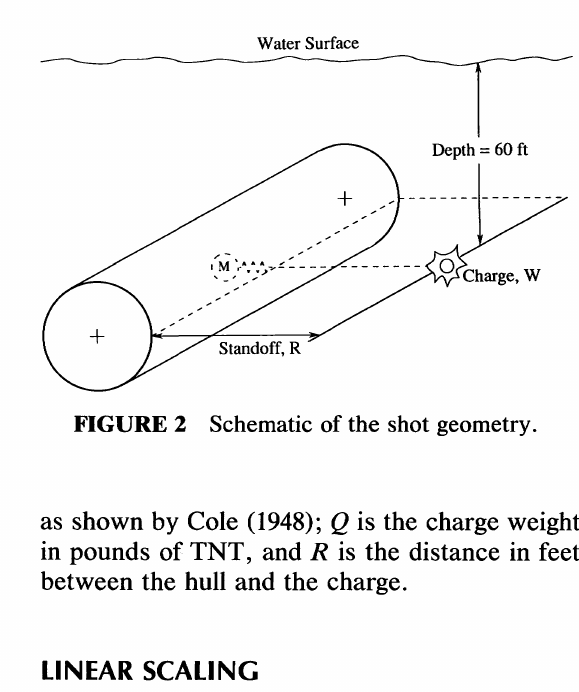
FIGURE 2 Schematic of the shot